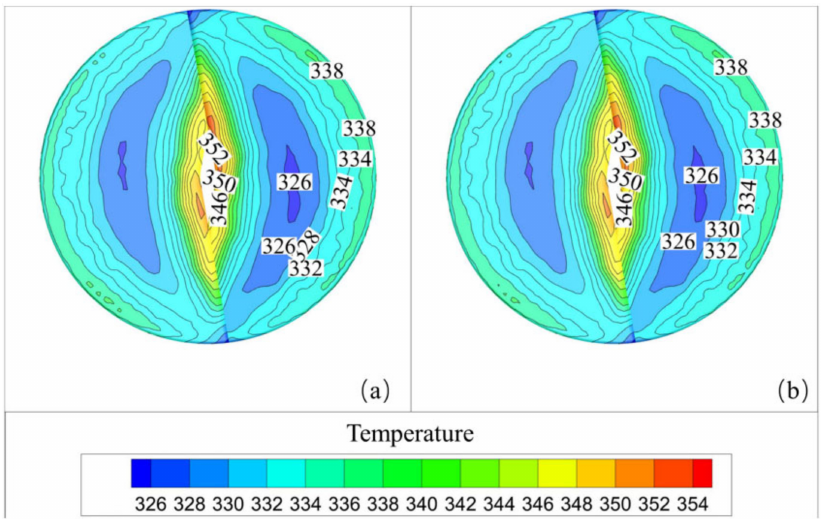
Figure 19. Simulation results considering temperature dependence of metal thermal conductivity: ( a ) thermal conductivity changing in response to temperature; ( b ) thermal conductivity not changing in response to temperature.